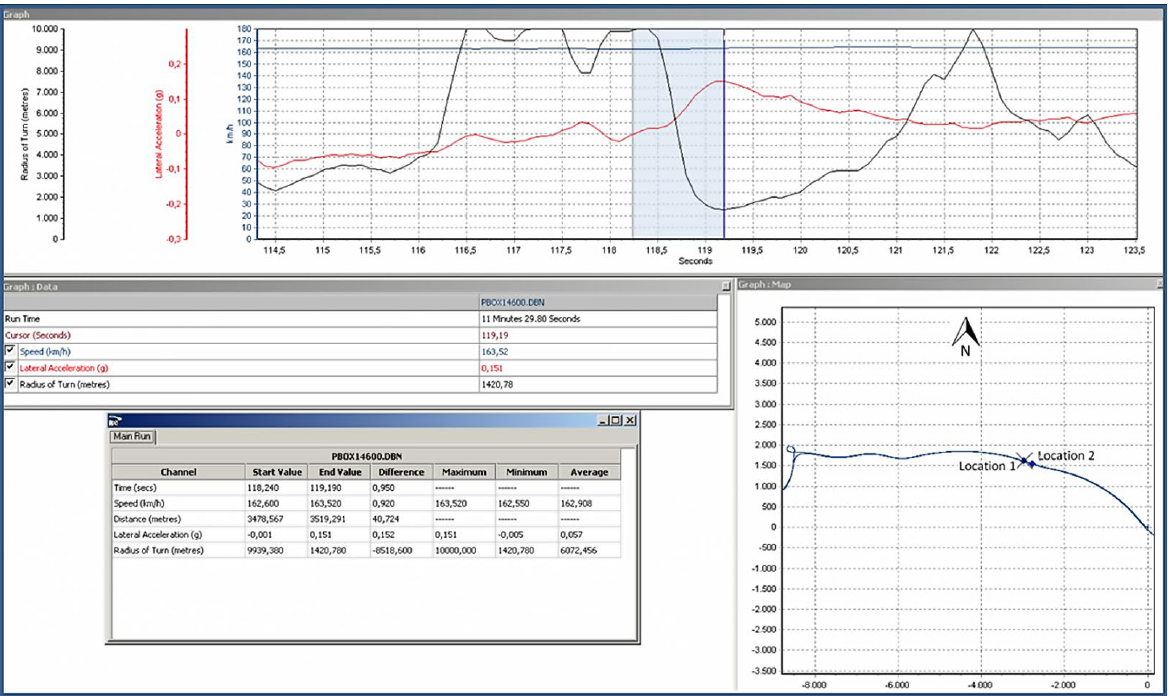
Fig. 2. Analysed data with PerformanceBox Tools